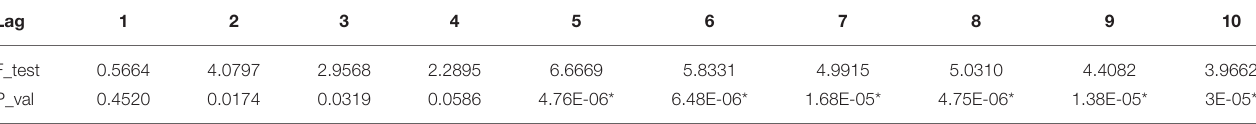
TABLE 1 | Granger causality test results.